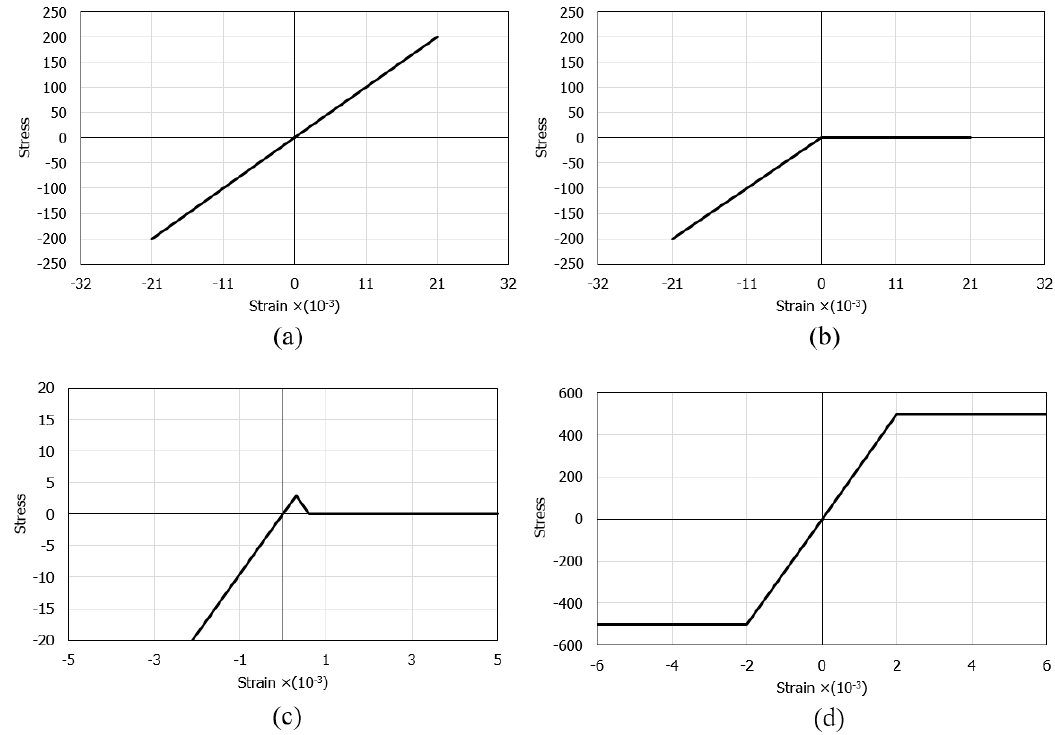
Figure 14. Stress-strain curves for ( a ) LM; ( b ) 1NLM; ( c ) 2NLM and ( d ) steel used in SAP2000 (values in MPa and m/m).